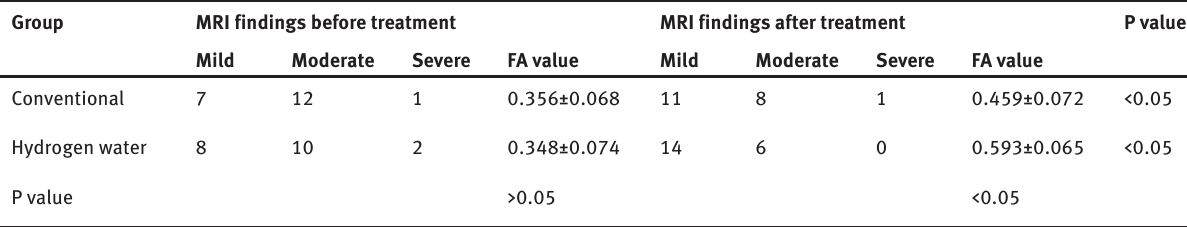
Table 4: A comparison of the serum NSE, IL-6, and TNF-α levels among the three groups of newborns. Group MRI findings before treatment MRI findings after